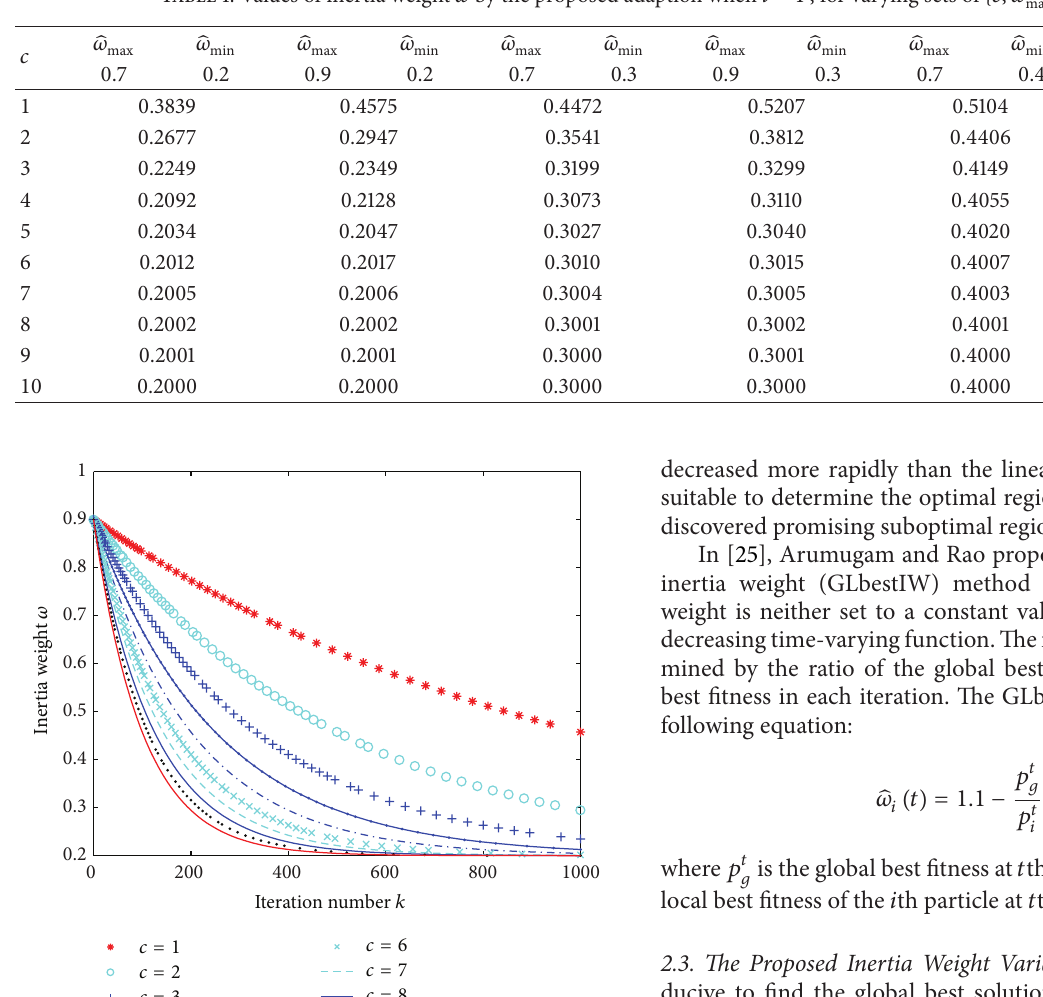
Table 1: Values of inertia weight ̂𝜔 by the proposed adaption when 𝑡 = 𝑇 , for varying sets of {𝑐 , ̂𝜔 max , ̂𝜔 min } .